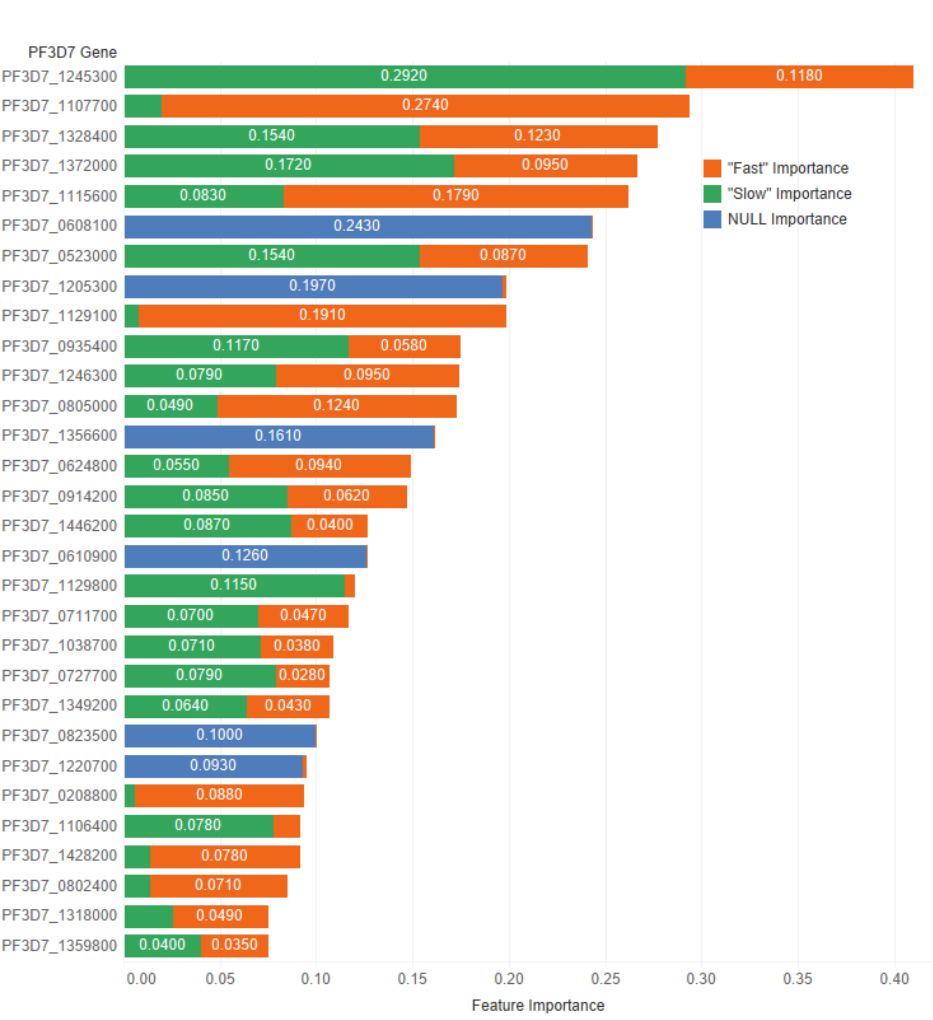
Figure 5. Precision-Recall curve of the clearance rate model.